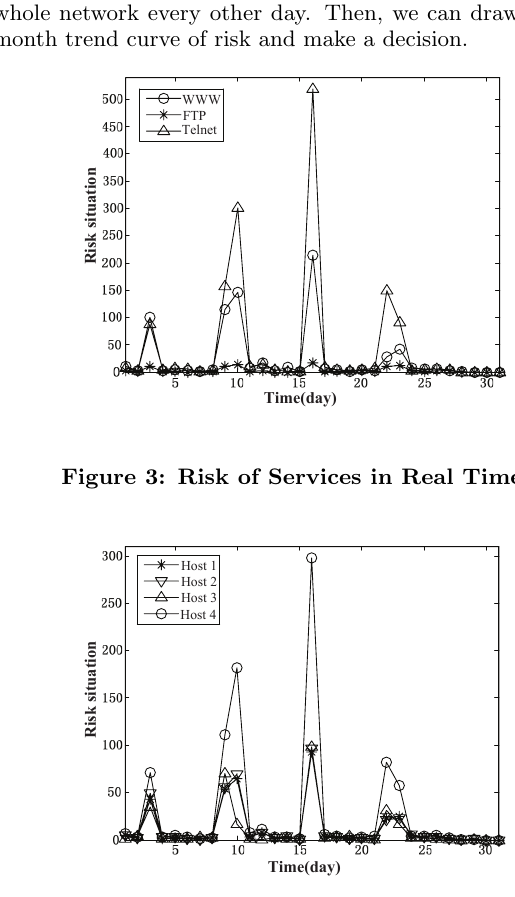
Figure 4: Risk of Hosts in Real